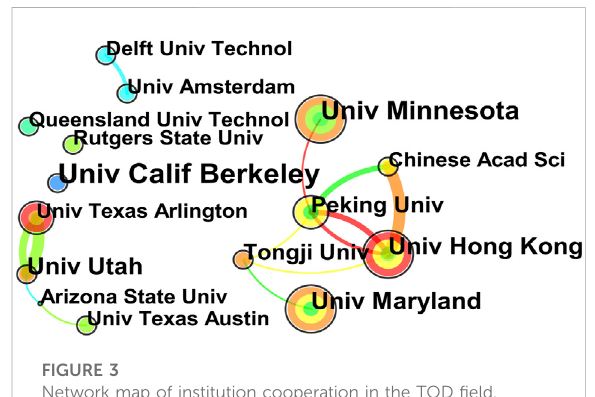
FIGURE 3 Network map of institution cooperation in the TOD fi